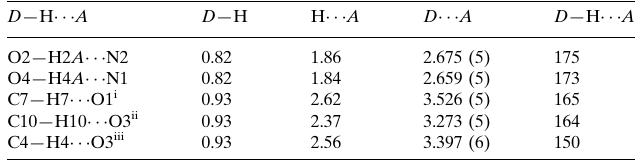
Hydrogen-bond geometry (A˚ , (cid:2)